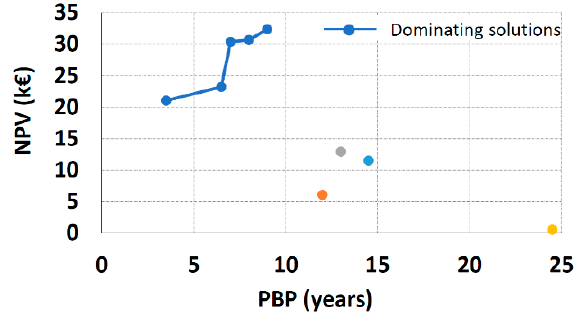
Figure 11. Example of the most economically feasible solutions (linked dots) selected using the “dominating” criterion among the possible ones. (The possible solutions provided in the example are related to PRS class No. 3).